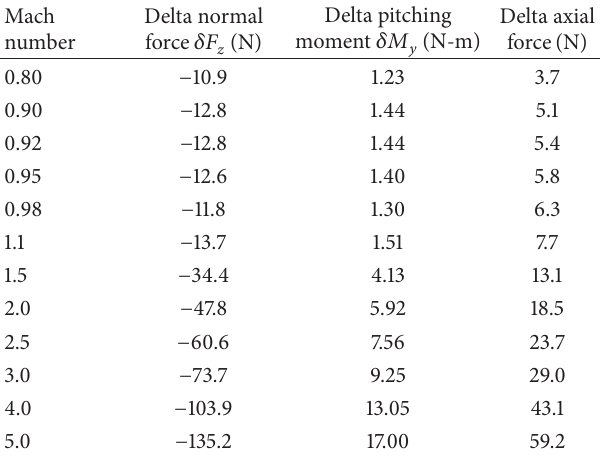
Table 7: Variation of delta forces and moments due to microflaps with Mach, 𝛼 = 0 ∘ .